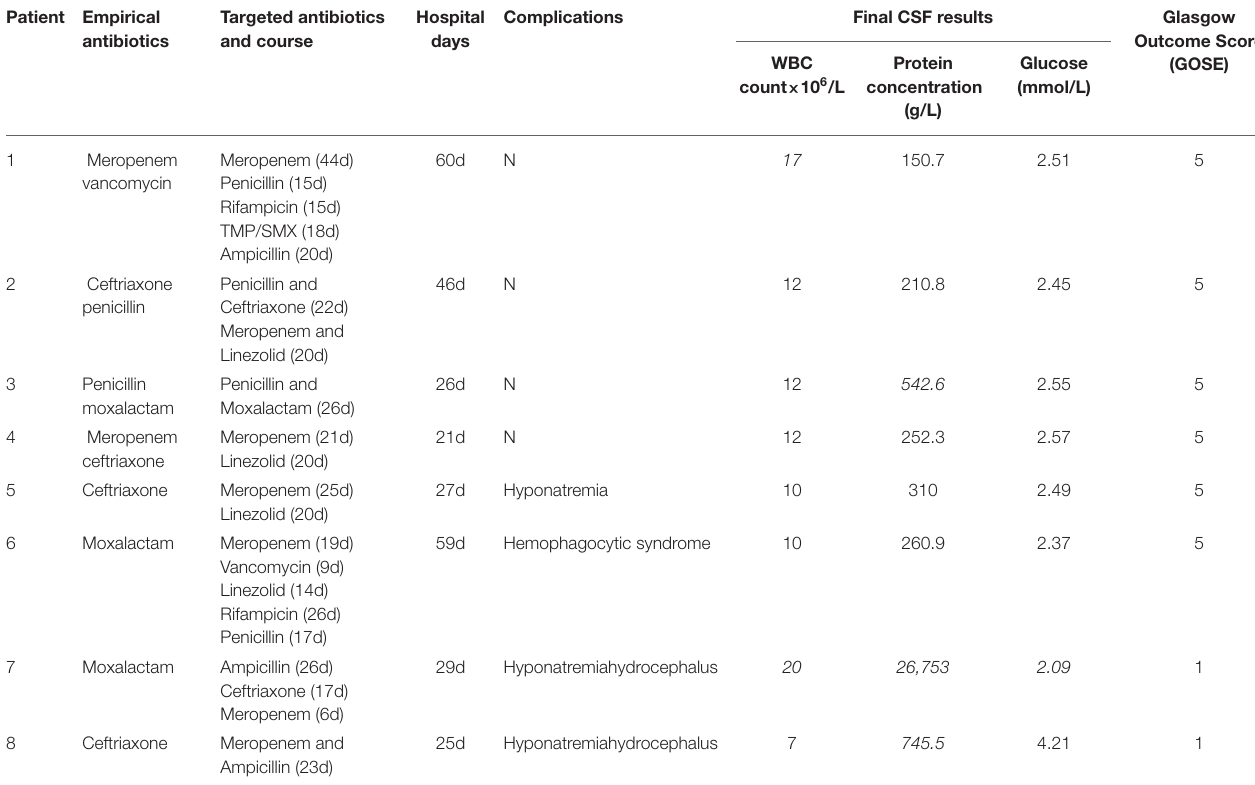
TABLE 4 | Summary of the anti-infective therapies, complications and outcomes of the patients. Patient Empirical